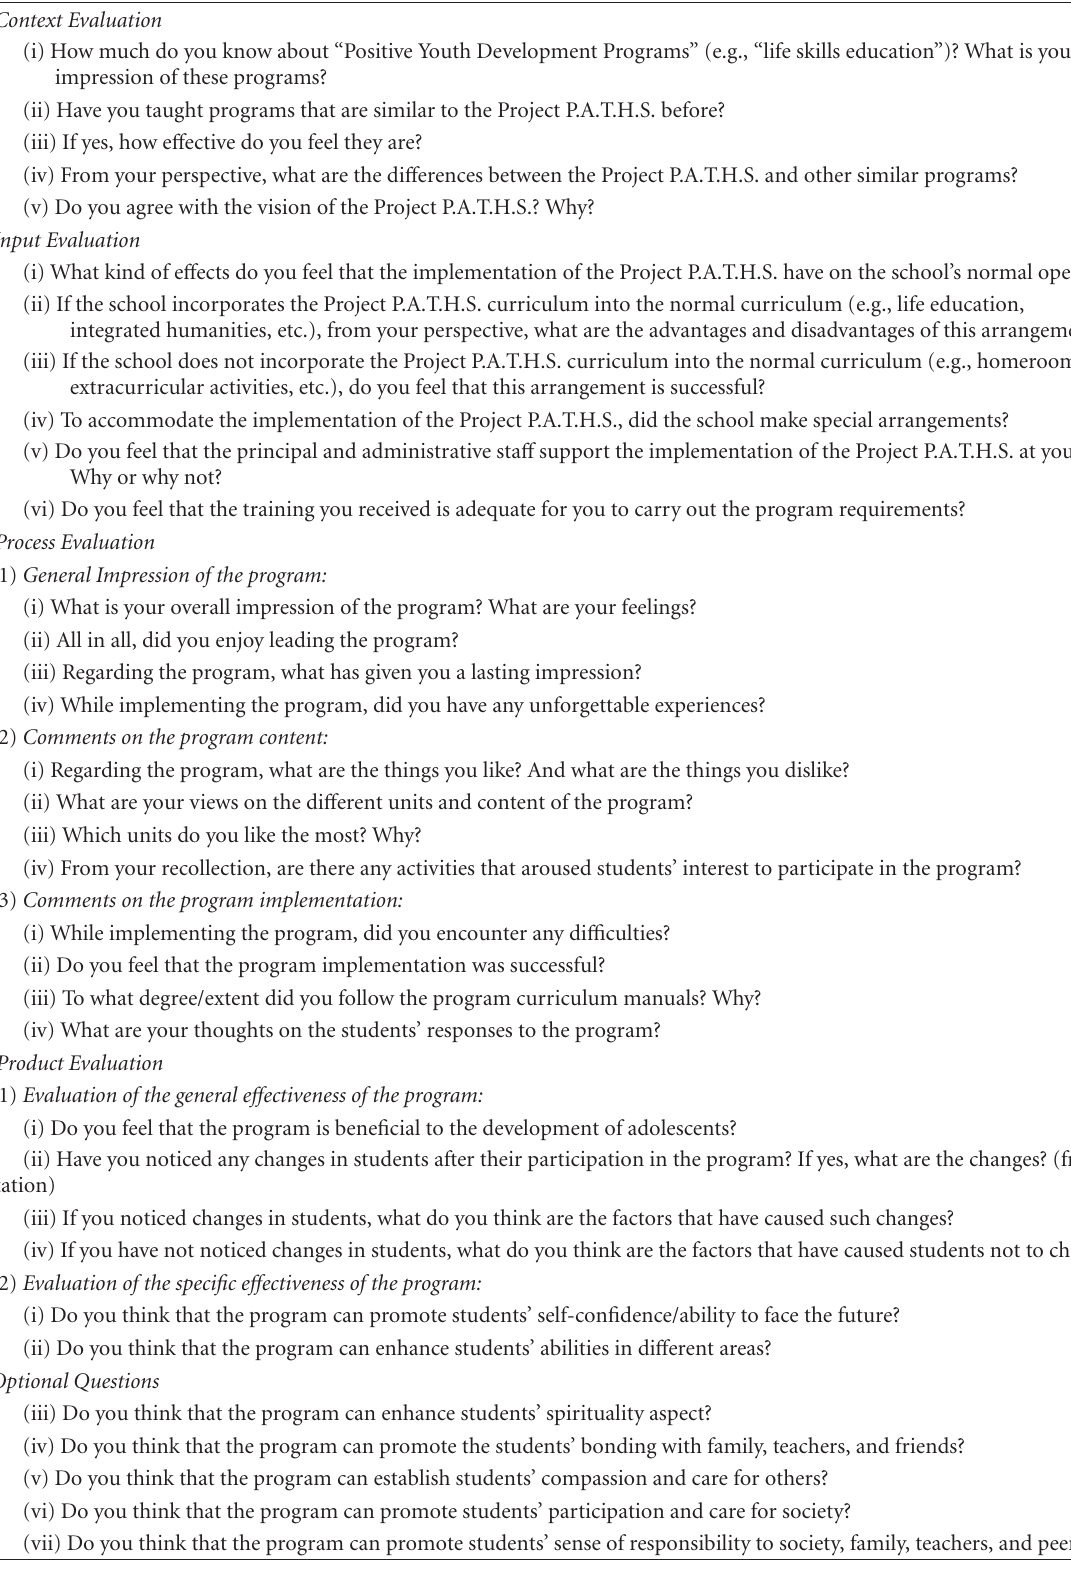
Table 2: Interview guide for the instructor focus